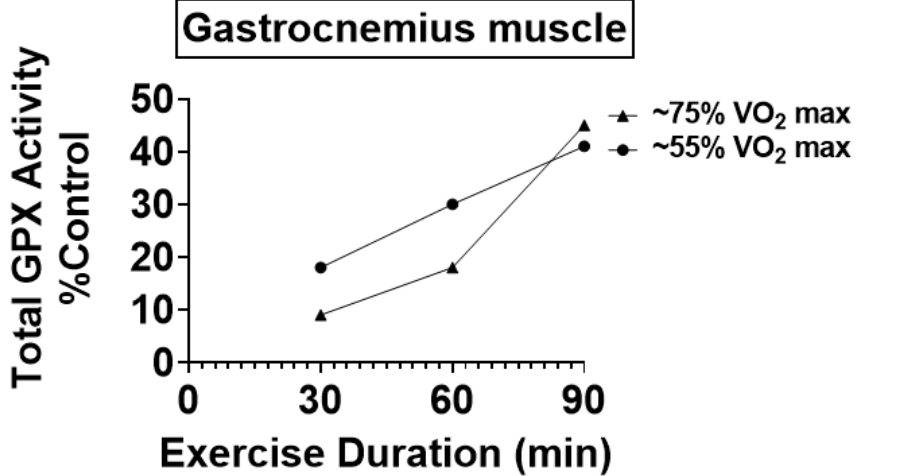
Figure 4. Illustration of the exercise dose – response increases in total SOD activity (SOD + SOD2) in the rat soleus muscle following 10 weeks of endurance exercise training. Data are from reference [51] .